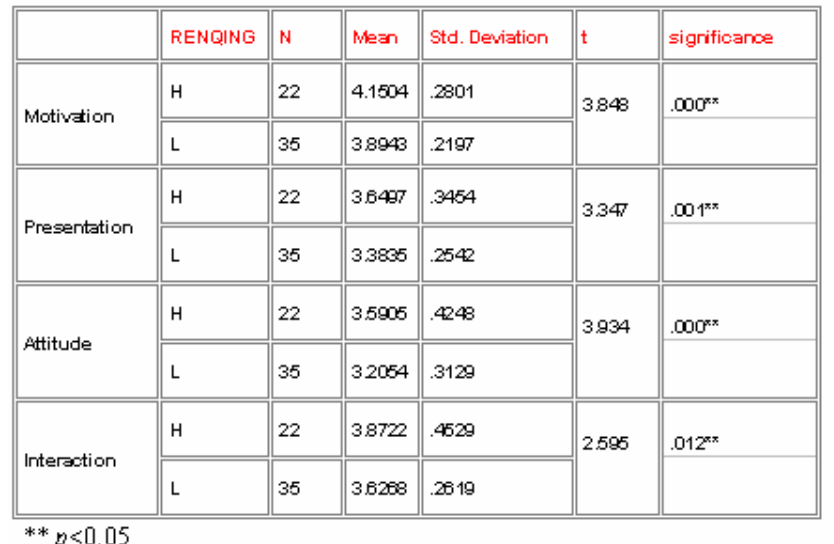
the Four Teaching